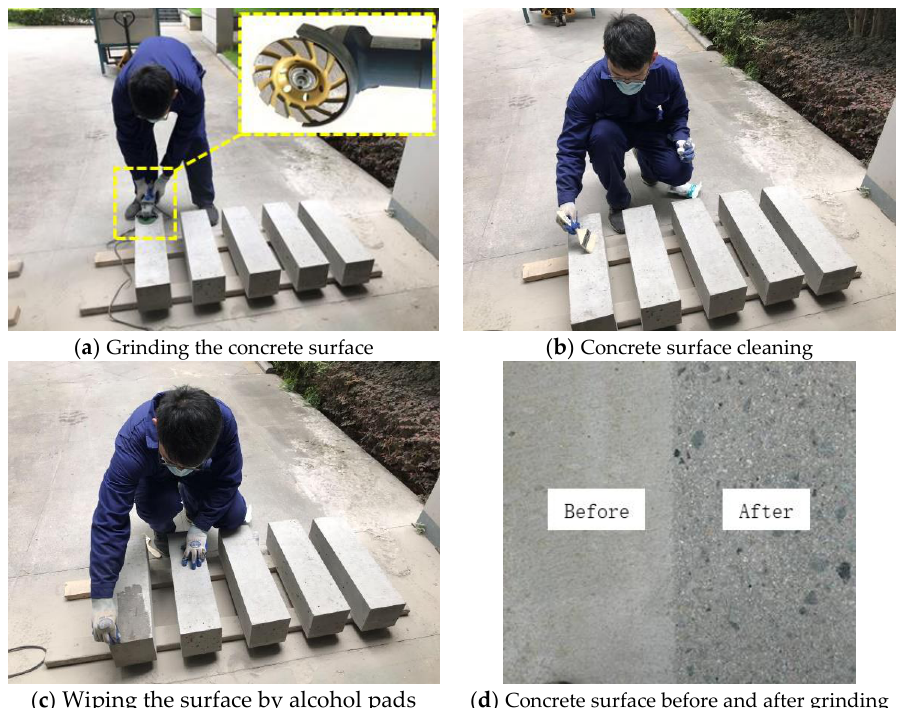
Figure 2. Concrete surface